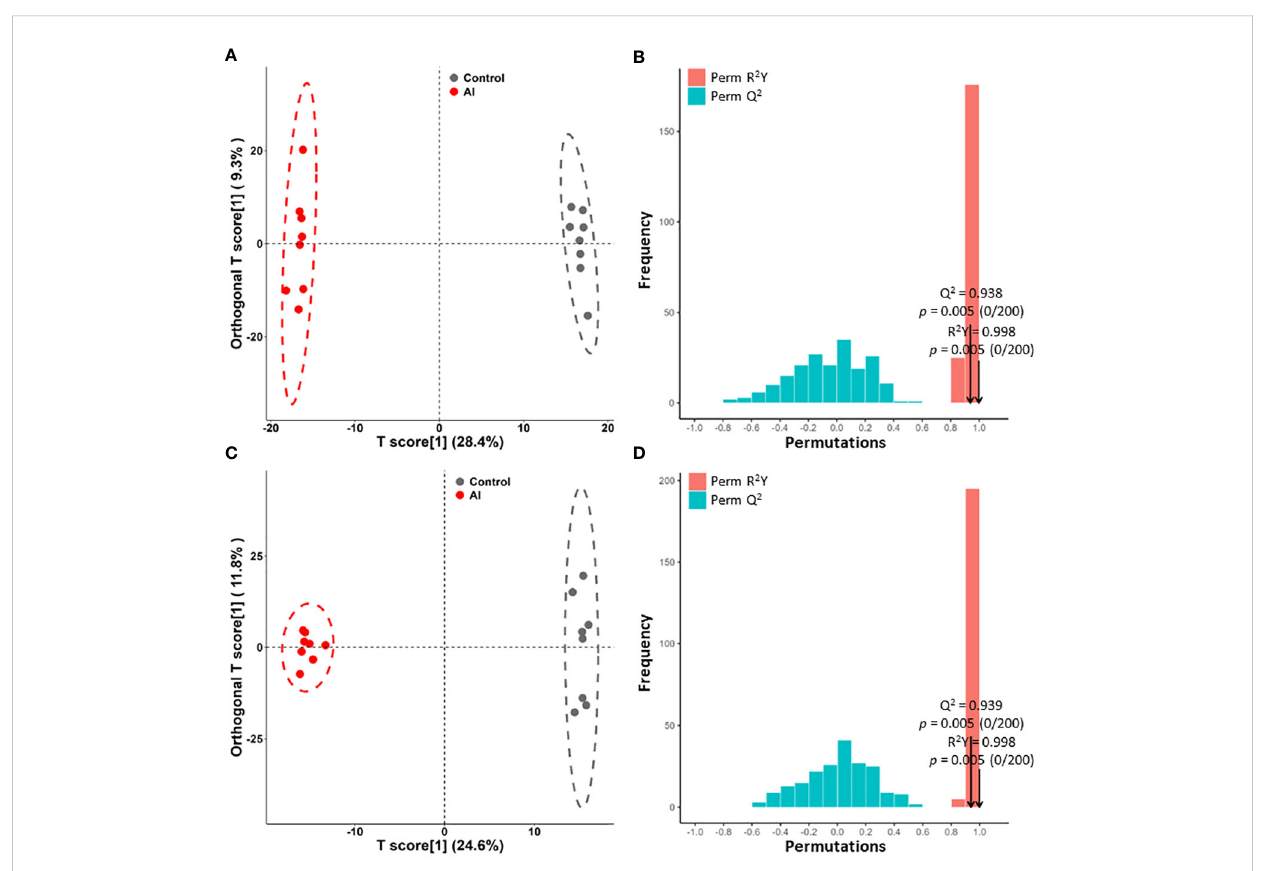
FIGURE 3 Orthogonal partial least squares discriminant analysis (OPLS-DA) of the metabolite pro fi le. (A, C) OPLS-DA score plots between the acutely infected group (AI) and the noninfected group (Ctrl) in ESI − mode (A) and ESI+ mode (C) . (B, D) OPLS-DA model with 200 permutation tests between AI and Ctrl in ESI − mode (B) and in ESI+ mode (D)